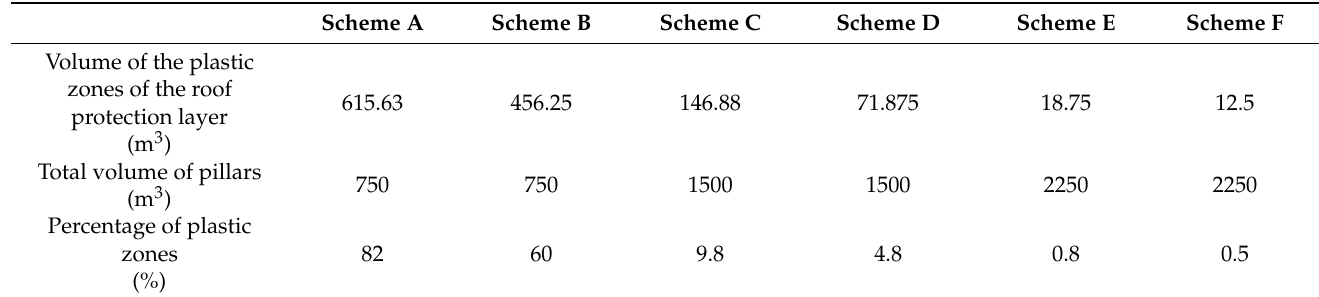
Figure 8. Distribution of plastic zones in the roof protection layer under Scheme F. Note that the heigt of each slice is 0.5m. ( a ) 3D drawing. ( b ) plan of roof protection layer (the first slice). ( c ) plan of roof protection layer (the second slice). ( d ) plan of roof protection layer (the thirdslice). The roof protection layer plastic zone volumes and percentages obtained under different extraction schemes are listed in Table 10. As the numerically simulated plastic